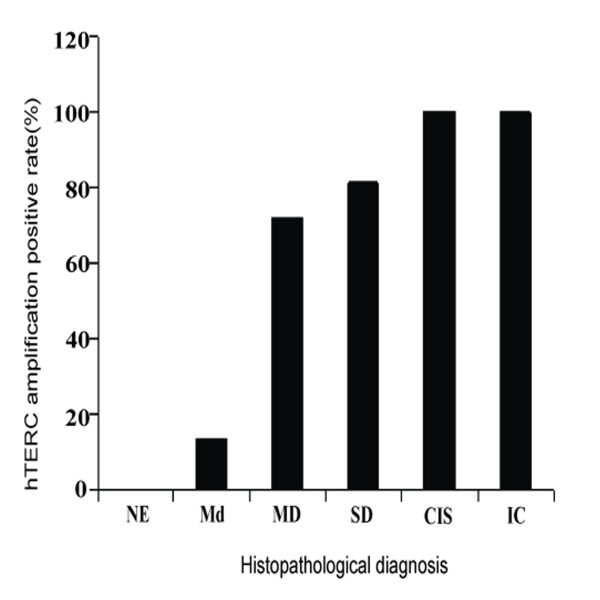
The increasing trend of hTERC amplification positive rates associated with the severity of laryngeal lesions, for histopathologic diagnosis.